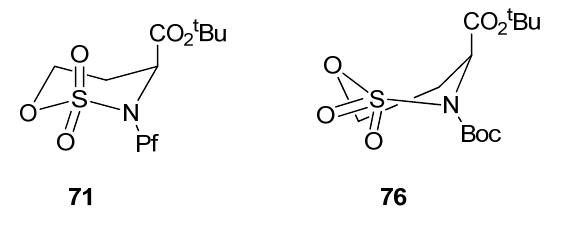
Figure 11. Conformations of N -Pf sulfamidate and N -Boc